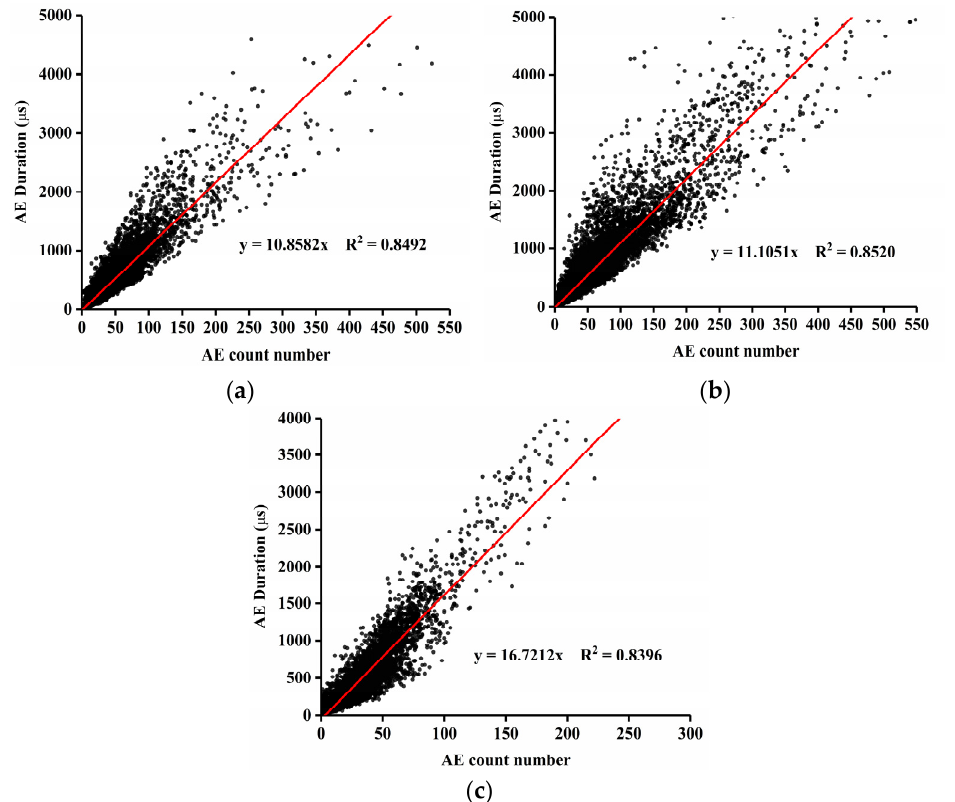
Figure 11. Fracture mechanism analysis of mortar rubble. ( a ) SRB-1. ( b ) SRG-1. ( c ) SRL-1.